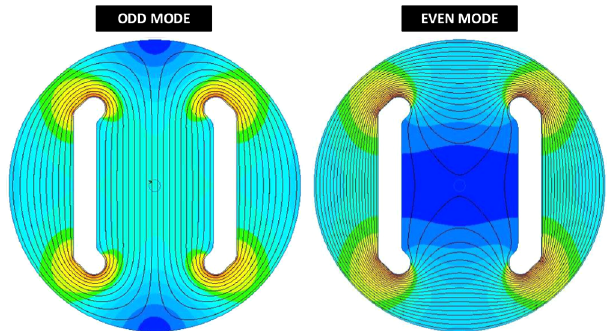
FIG. 3. Electric field pattern for the odd (left) and even (right) modes. The color pattern goes from orange (maximum electric field) to dark blue (zero electric